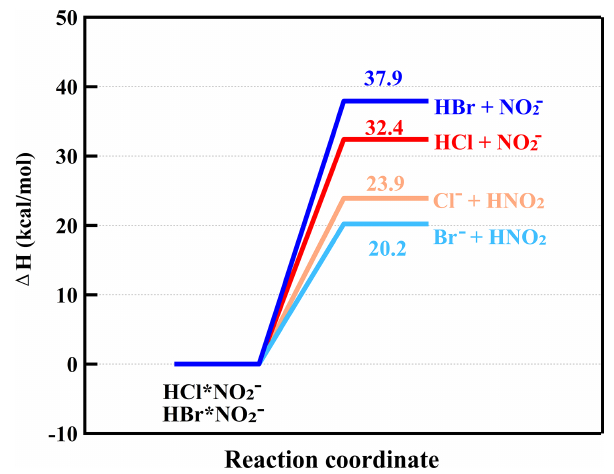
(cid:113) NO − formed by HCl 2 (cid:113) NO − 2